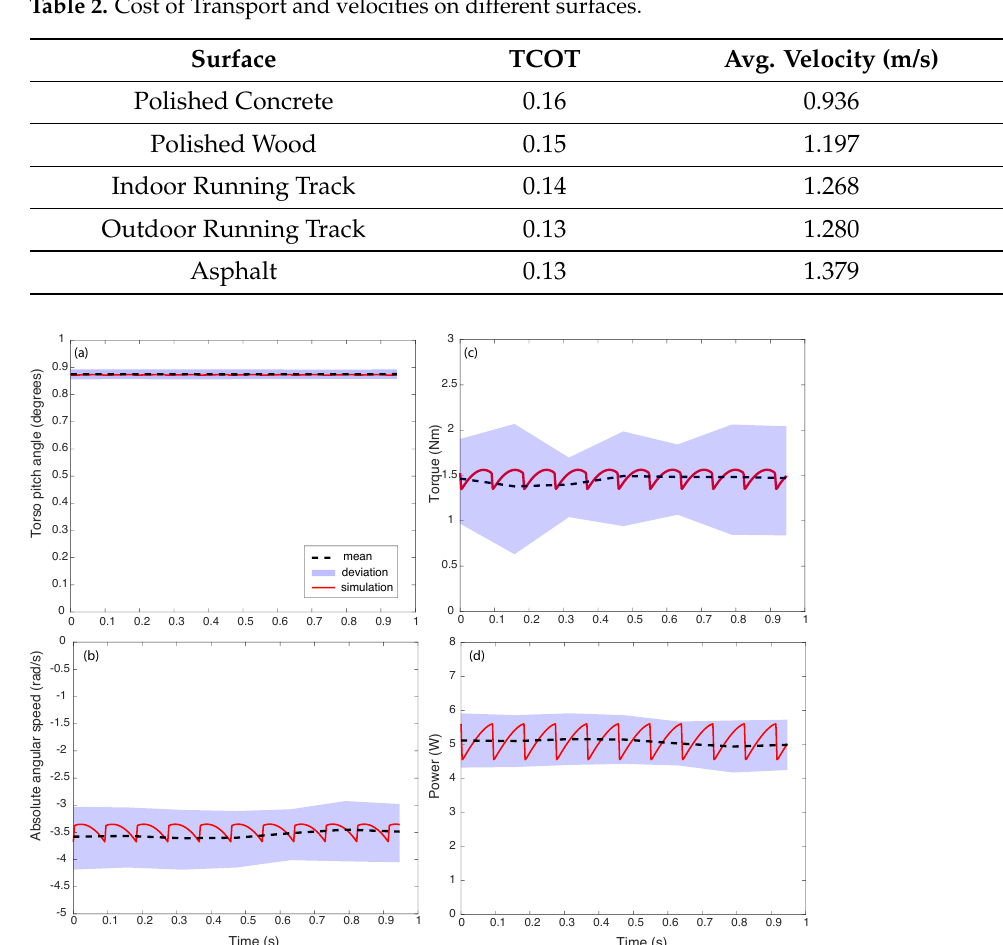
Figure 7. Experimental data for straight line motion for 1 complete revolution or 10 steps of the rimless wheel: ( a ) Torso pitch, ( b ) absolute speed of the robot, ( c ) motor torque, and ( d ) power, all as a function of time. The mean is shown with black dashed line and the blue bands show one standard deviation. The simulation data is shown by red solid line. The measurements had considerable noise leading to a relatively large standard